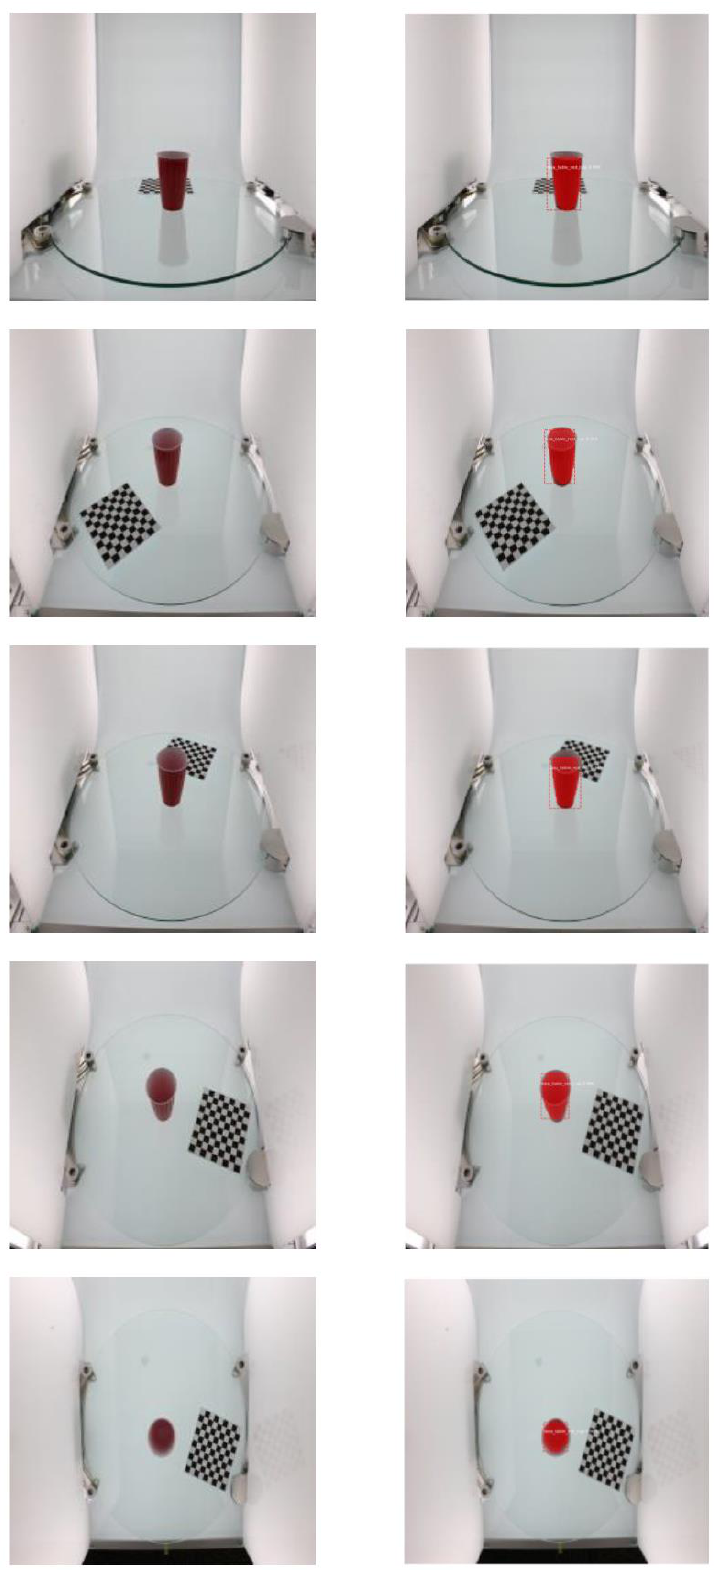
Figure 13. Results for ikea_table_red_cup data using the Mask R-CNN-based object detection method. The column on the left contains the input images. The column on the right shows the positioning and segmentation